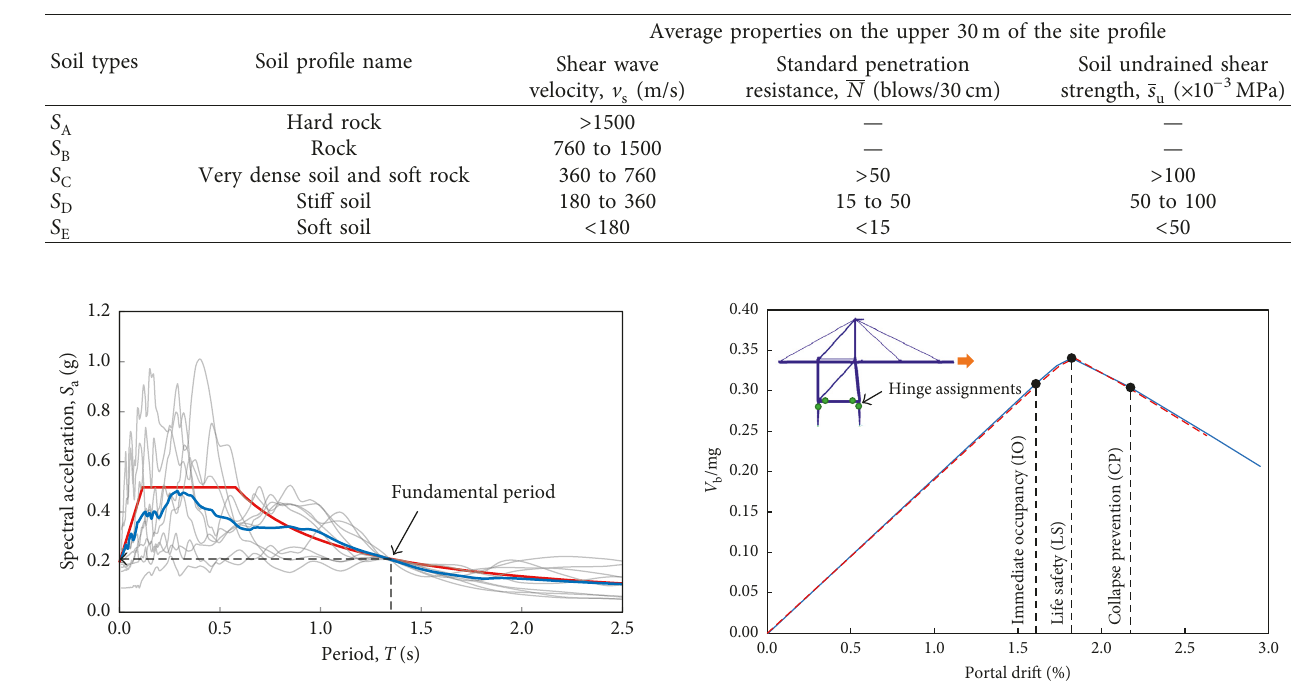
Table 3: Site classification of KBC 2016.